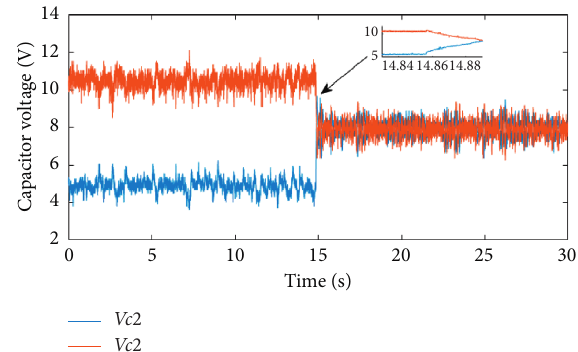
Figure 10: The experimental waveform of Vc 1 and Vc 2 before and after incorporating the capacitor voltages balance